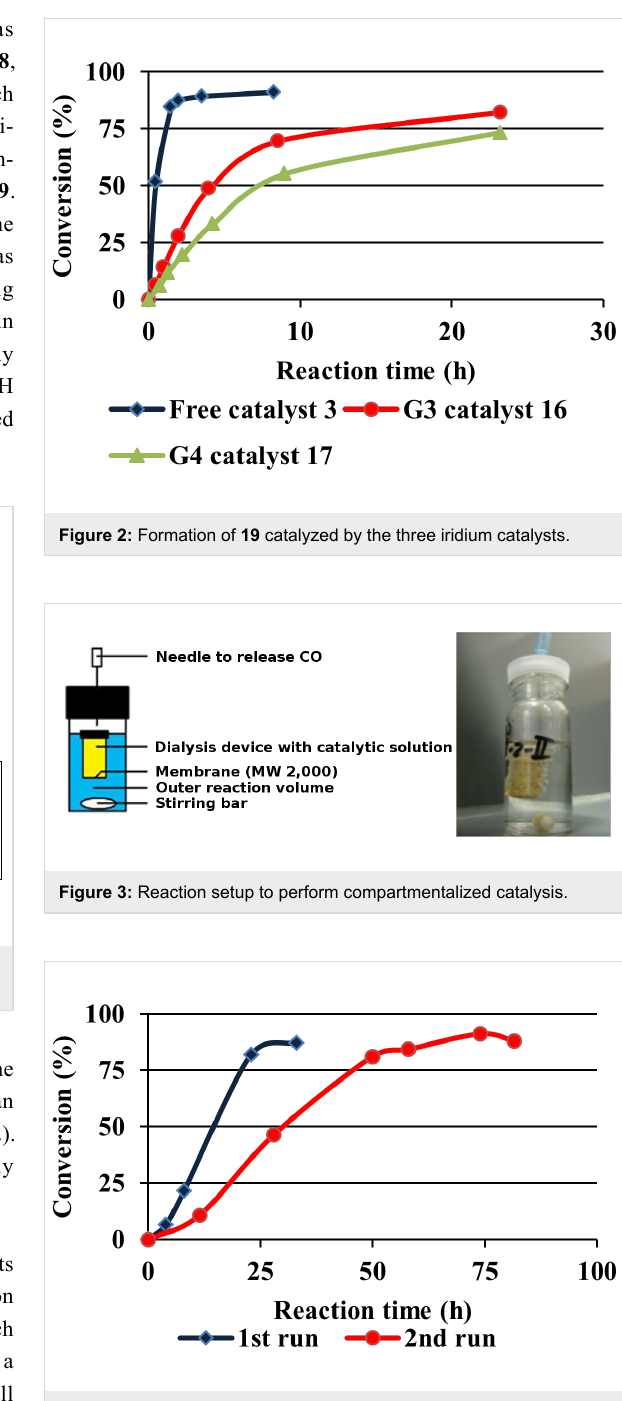
Figure 4: G3 catalyst 16 activity in dialysis